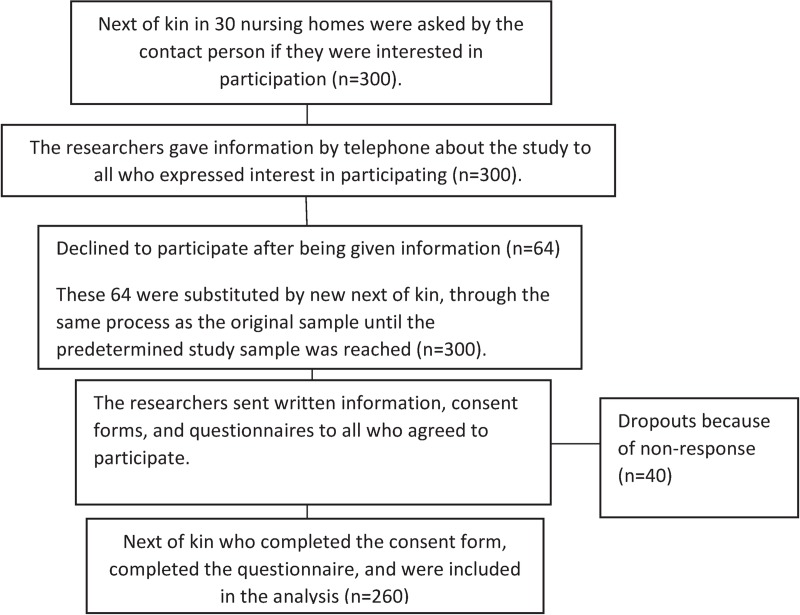
Flowchart illustrating the inclusion procedure of next of kin in this study.